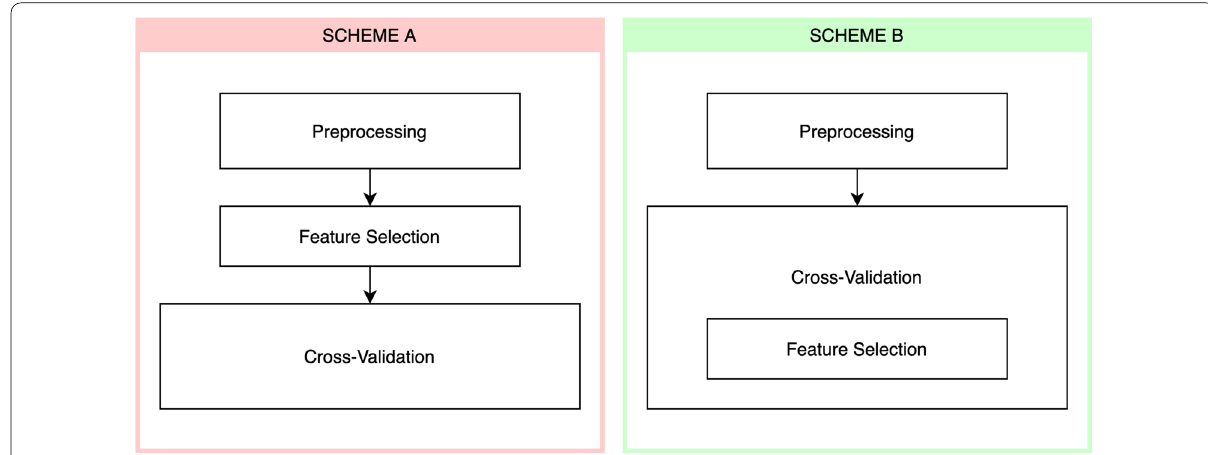
Fig. 1 Illustration of the two training schemes used. In scheme A the feature selection is performed on the whole dataset before the cross-validation, while in scheme B the feature selection is part of the cross-validation, i.e. is applied only to each training fold. Note that preprocessing actually must be part of the cross-validation, but as it would interfere with the bias coming from applying the feature selection incorrectly, it was applied to all